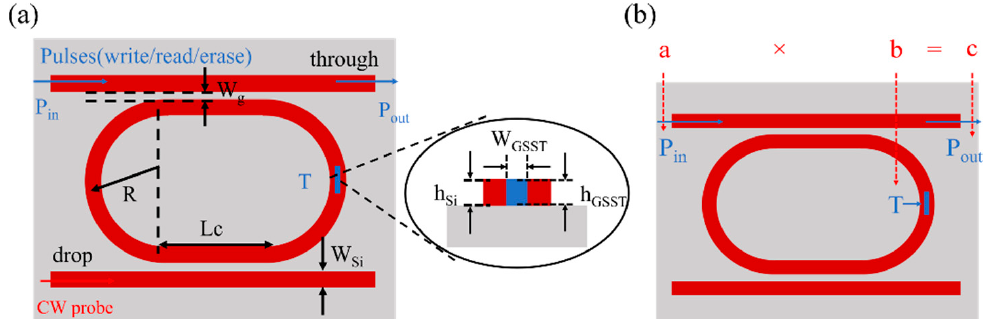
Figure 1. ( a ) Device structure of a racetrack resonator based on GSST-slot. A bidirectional pump- probe scheme can be employed for write/erase and readout operations. Inset is a cross-sectional view along the GSST-Si slot waveguide. ( b ) Scalar multiplication of two numbers a × b = c, mapping numbers a and b to the read pulse P in and transmittance T of the device, respectively.